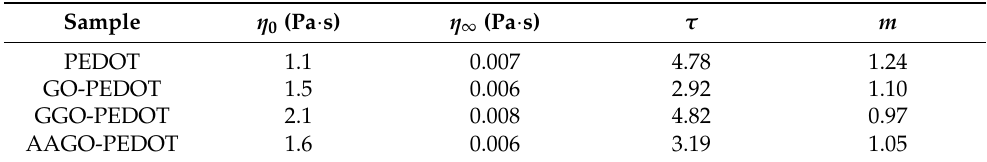
Table 1. Cross model’s parameters (Equation